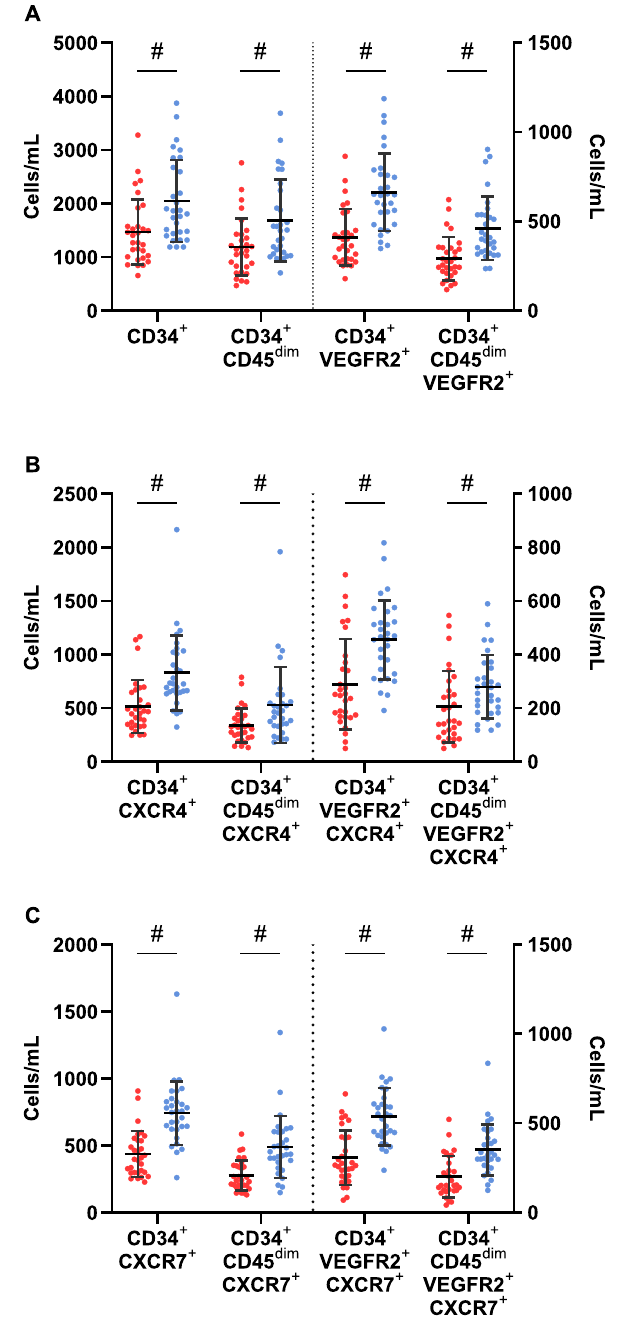
Figure 2. Resting circulating number of CD34 + , CD34 + CD45 dim HPCs and CD34 + VEGFR2 + , CD34 + CD45 dim VEGFR2 + EPCs ( A ), and the number of these cells expressing CXCR4 + ( B ) and CXCR7 + ( C ) between the type 1 diabetes (red circles) and non-diabetes (blue circles) groups. #—signifies significant difference between the type 1 diabetes and non-diabetes groups. Data shown are mean ±